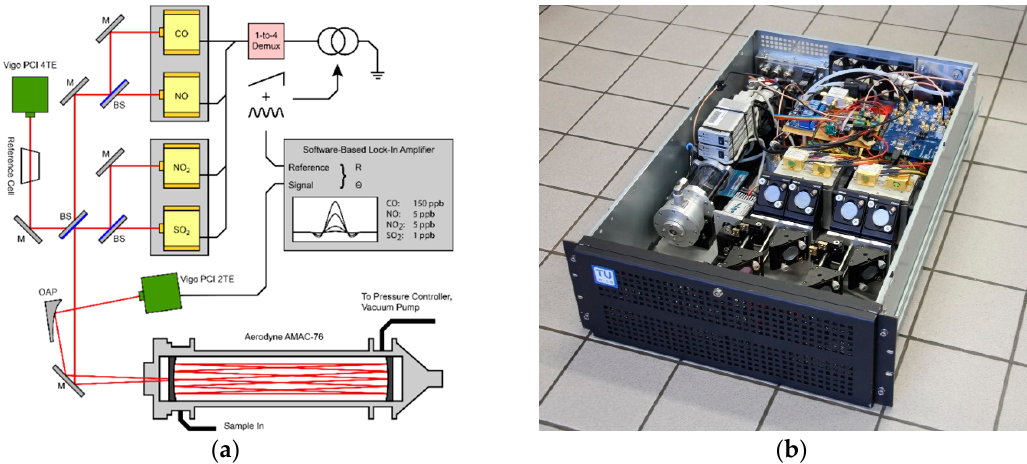
Figure 3. Schematic layout of the individual components for the 2f-WMS based sensor ( a ) and the assembly of the optical setup in a standard 19” server rack ( b ). The laser driver, data-acquisition-card, power supplies and the measurement PC are installed in a second rack (not shown).